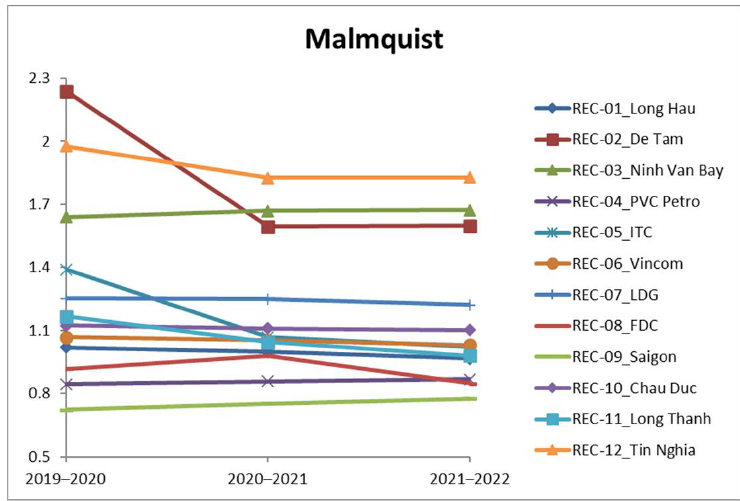
Figure 9. Total factor productivity change.